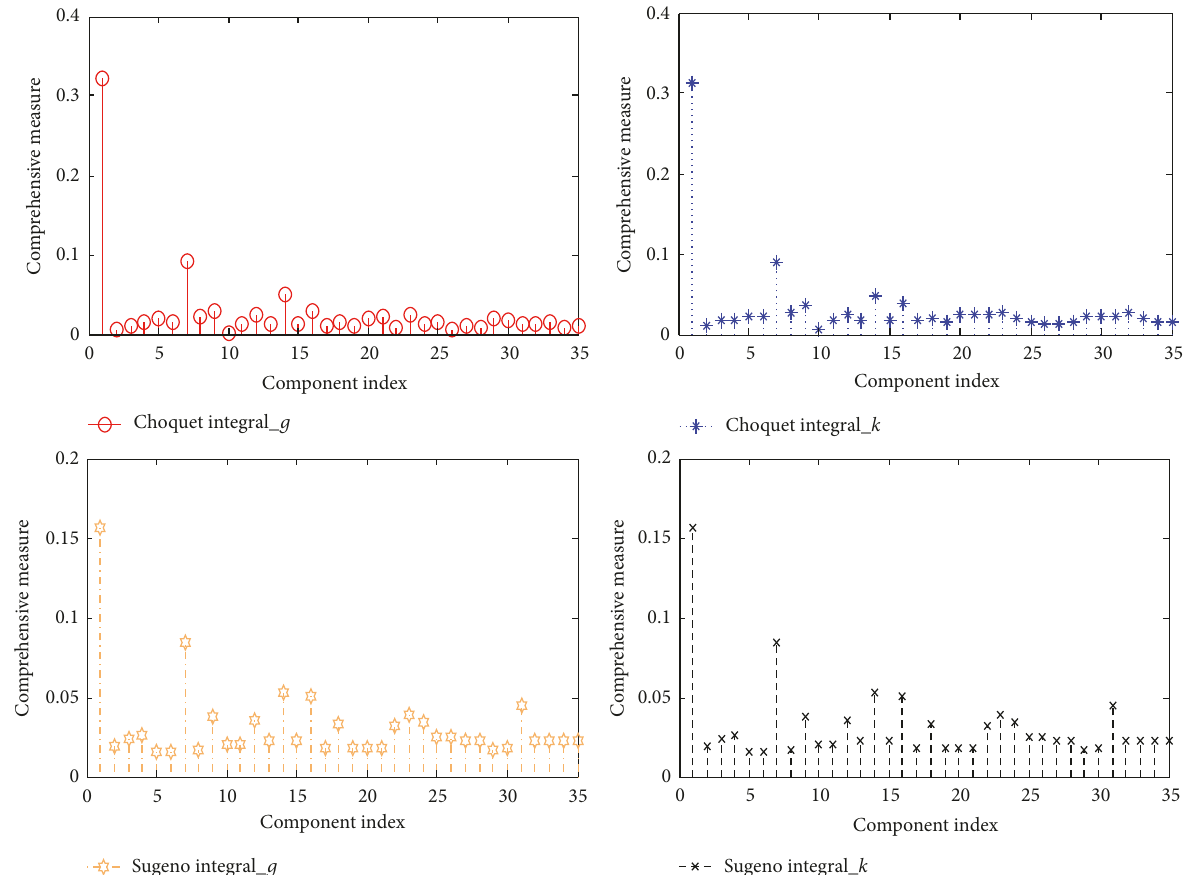
Figure 9: Influential components of bogie